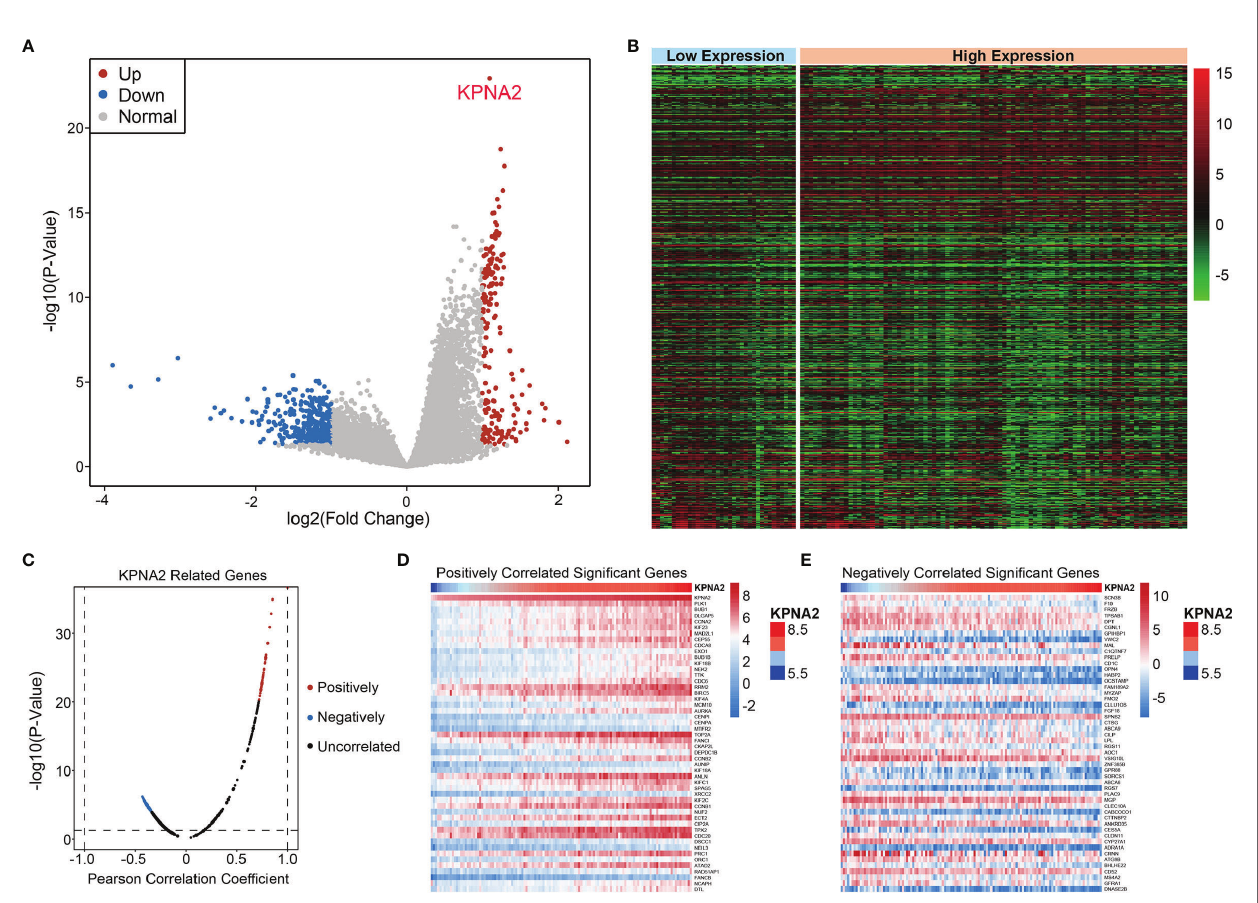
FIGURE 3 | Identi fi cation of KPNA2 co-expression gene. (A) Volcano plot of DEGs associated with KPNA2 expression. Red denotes elevated DEGs, blue denotes suppressed DEGs, while gray denotes non-differential genes. (B) Heat map of DEGs. (C) Pearson test was used to assess the association between KPNA2 and DEGs. (D, E) The heat map shows genes positively and negatively correlated with KPNA2 (Top